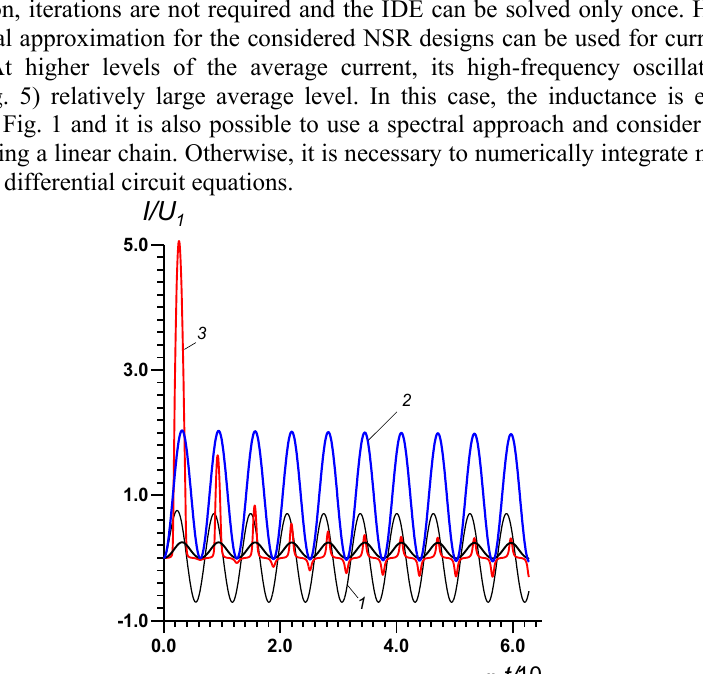
Fig. 4. Establishing of a transient process in a circuit with nonlinear normalized inductance L 0 = 0.1, (curves 2, 3) when a harmonic source is switched on. Curve 1 is linear case (zero harmonic U 0 =0); 2 and 3 - values I/U 1 and 10 I/U 1 respectively for first harmonic of voltage U 1 =10 2 and U 1 =10 3 .